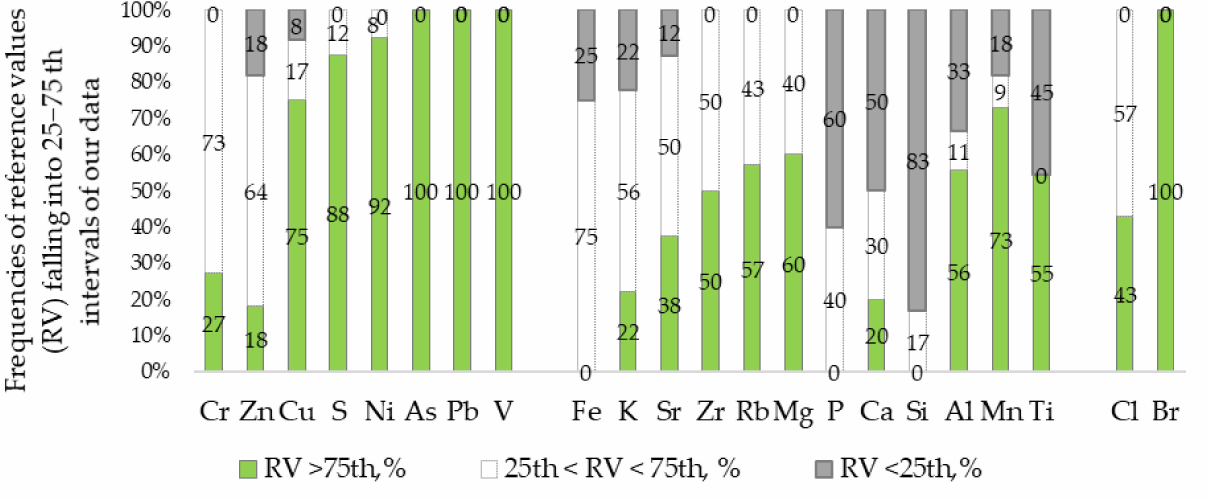
Figure 5. Correspondence of our analysis data to reference values (RV) given in Table S3. The analytes are sorted according to descending frequency of RV within our 25th–75th percentile interval. These frequencies are in white parts of the columns, the frequencies of RV exceeding our 75th percentile are in green parts, while those below our 25th percentiles are in gray parts.